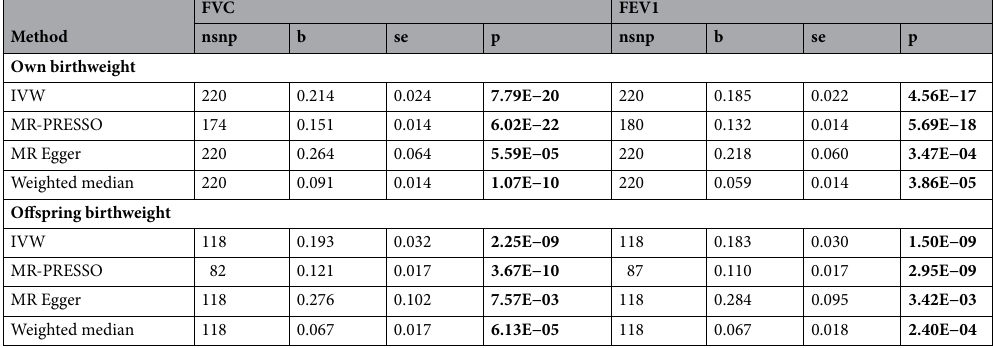
Table 1. Mendelian randomisation analyses of birth weight with expiratory volume in 1 s (FEV1) and forced vital capacity (FVC). The estimates represent SD change in outcome variable per SD change in the exposure tested. P-values significant after Bonferroni correction (p ≤ 1.25*10 −1 ) are bold. se, standard error; P, p-value; nsnp, number of single-nucleotide polymorphism; IVW, inverse variance weighted